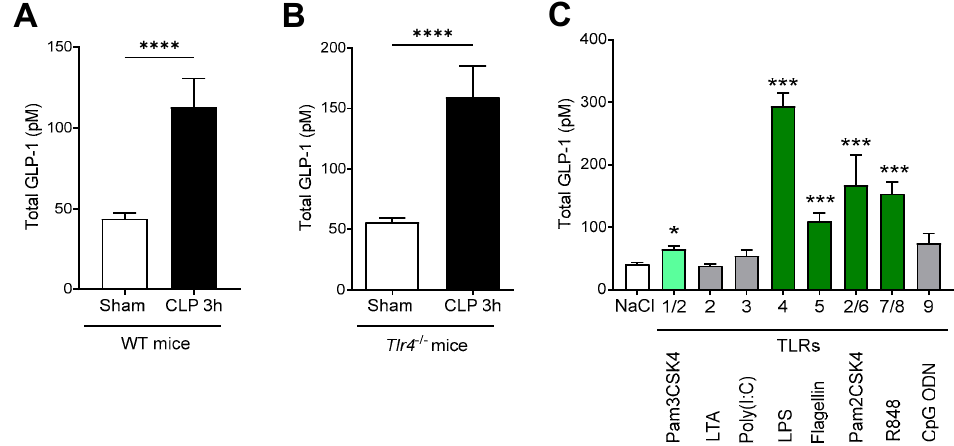
Figure 3. Glucagon-like peptide 1 (GLP-1) secretion is mediated through multiple toll-like receptors (TLRs). ( A ) Total GLP-1 plasma levels (pM) 3 h after the onset of cecal ligation puncture (CLP; n = 10) or in sham control mice ( n = 10) in wild-type (WT) mice. ( B ) Total GLP-1 plasma levels (pM) 3 h after the onset of CLP ( n = 11) or in sham control mice ( n = 10) in TLR4-deficient ( Tlr4 -/- ) mice. ( C ) Total GLP-1 plasma levels in mice 3 h after an intraperitoneal injection of sodium chloride (NaCl; control group; n = 9) or different TLR agonists: Pam3CysSerLys4 (Pam3CSK4; TLR1/2 agonist; 1 mg/kg; n = 5), lipoteichoic acid (LTA; TLR2 agonist; 1 mg/kg; n = 5), Pam2CysSerLys4 (Pam2CSK4; TLR2/6 agonist; 1 mg/kg; n = 5), polyinosinic-polycytidylic acid (Poly(I:C); TLR3 agonist; 1 mg/kg; n = 5), lipopolysaccharides (LPS; TLR4 agonist; 1 mg/kg; n = 9), flagellin (TLR5 agonist, 1 mg/kg; n = 5), resiquimod (R848; TLR7/8 agonist; 1 mg/kg; n = 5) and CpG oligodeoxynucleotides (CpG ODN; TLR9 agonist; 0.6 mg/kg; n = 5). Statistical analyses were performed using the